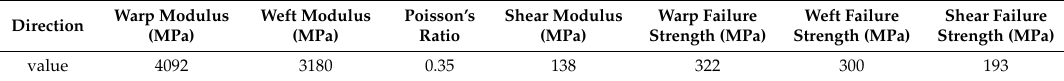
Table 1. Mechanical parameters of envelope Uretek-3216LV [29].